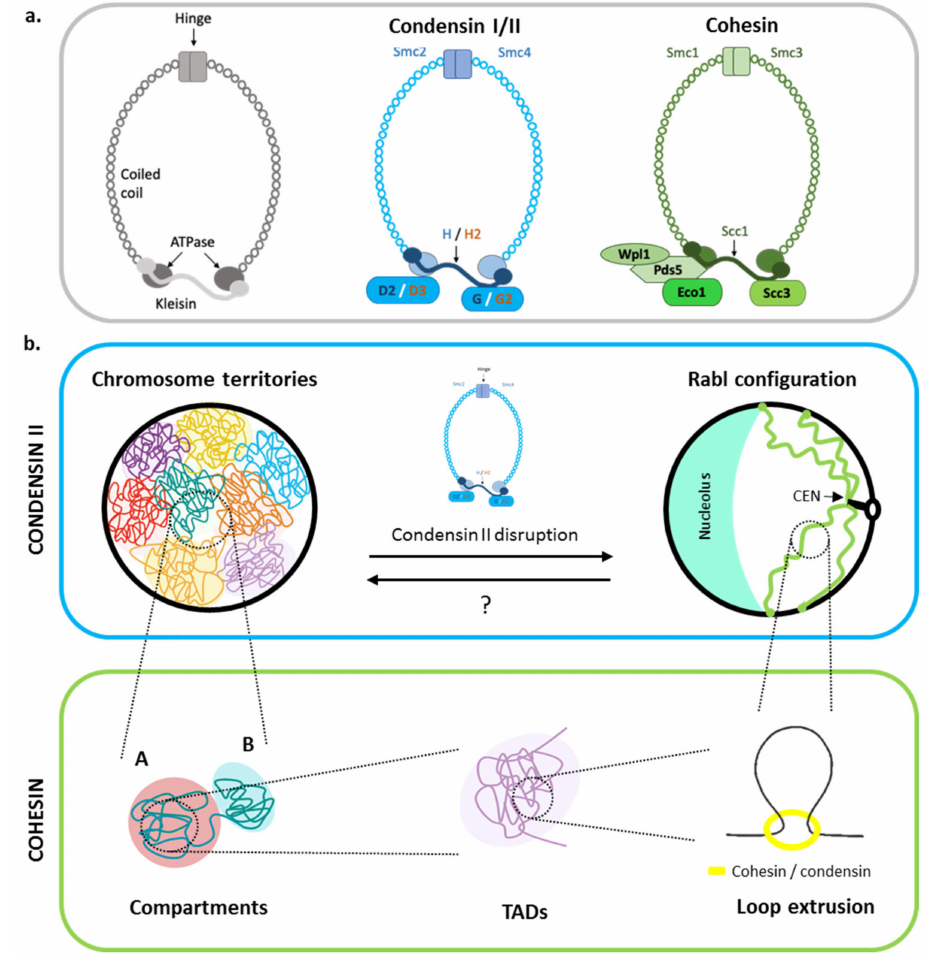
Figure 1. Chromatin organization and the role of SMC complexes. SMC complexes organize the chromatin architecture at different levels. ( a ) Left: Overview of the SMC complex in S. cerevisiae . The SMC subunits have a coiled–coil domain that forms a dimmer (hinge) and the ATPase held together by a kleisin. Middle: Condensins I (blue subunits) and II (orange subunits) are composed of Smc2 and Smc4 held together by kleisin H in condensin I, and H2 in condensin II. In addition, the condensins have a pair of HEAT subunits, named D2 and G in condensin I and D3 and G2 in condensin II [22]. Right: The cohesins (green) are formed by Smc1 and Smc3 linked by Scc1. It has regulatory subunits such as Scc3, Wpl1, Eco1, and Pds5 [21]. ( b ) Condensin II organizes chromosomes on a large scale. Its presence allows for the organization of chromatin into chromosomal territories. The absence of this complex results in the organization of chromosomes in a Rabl configuration